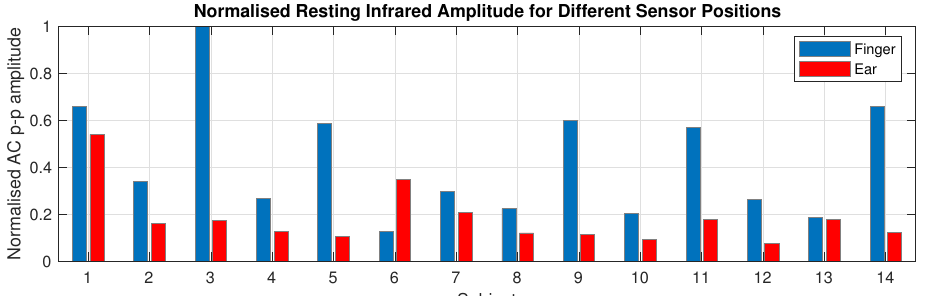
Figure 9. The mean resting maximum to minimum AC amplitude of the photoplethysmography signal for all subjects. These values were measured from the 60 s of filtered PPG data before the first breath hold and were normalised to the maximum mean AC amplitude across all